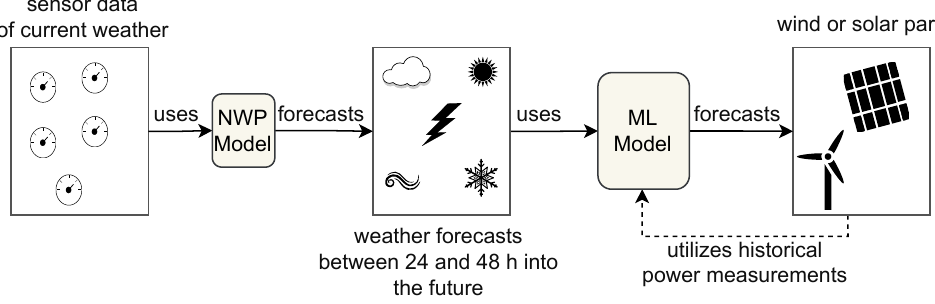
Figure 5. Overview of renewable power forecast process.